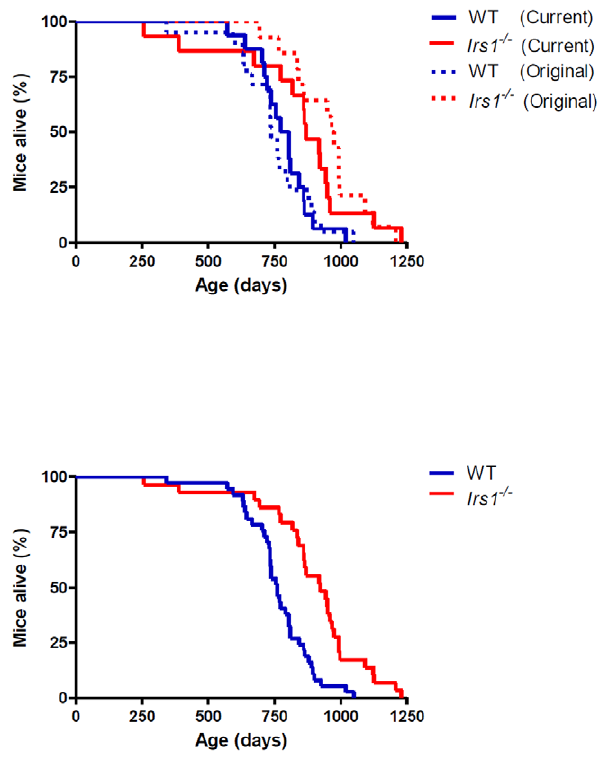
Figure 1. Female Irs1 2 / 2 mice are significantly long-lived. Kaplan-Meier survival curves for female WT and Irs1 2 / 2 mice from this current study (Solid lines; under husbandry conditions exactly as previously described [12,16]) and our original study (Stippled lines; [12]). Blue and red lines indicate WT and Irs1 2 / 2 mice respectively ( A ). Kaplan-Meier survival curves for the combined data for female WT and Irs1 2 / 2 mice from this current study and our original study ([12]). Blue and red lines indicate WT and Irs1 2 / 2 mice respectively ( B ). PLoS ONE |